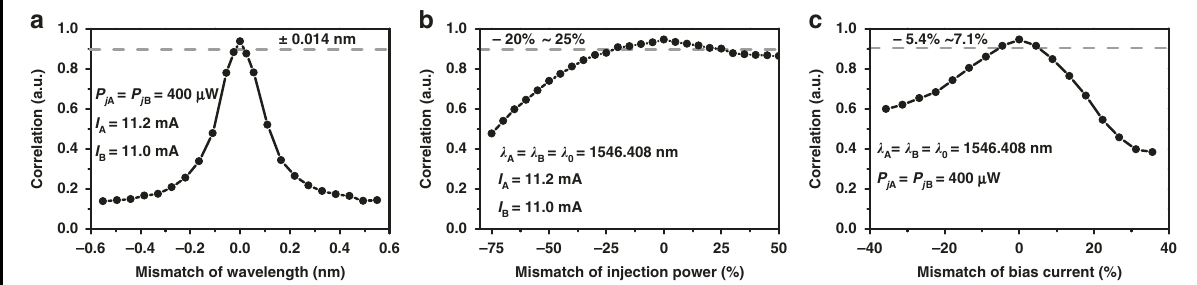
Fig. 3 Effects of parameters mismatch on chaos synchronization of the λ 0 modes. a Center wavelength mismatch, b injection power mismatch, and c bias current mismatch. Original settings: center wavelength λ A = λ B = λ 0 = 1546.408 nm, bias currents I A = 11.2 mA, I B = 11.0 mA, injection power P j A = P j B = 400 μ W.